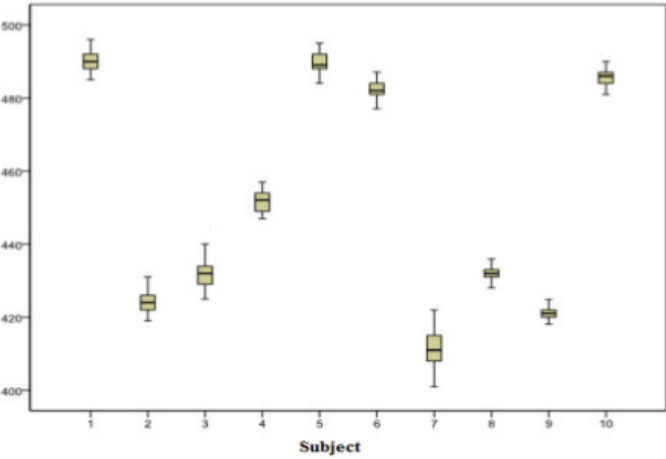
Figure 1: The box and whisker plots for CCT measurements in micrometers ( y -axis) for the right eyes of the 10 subjects.